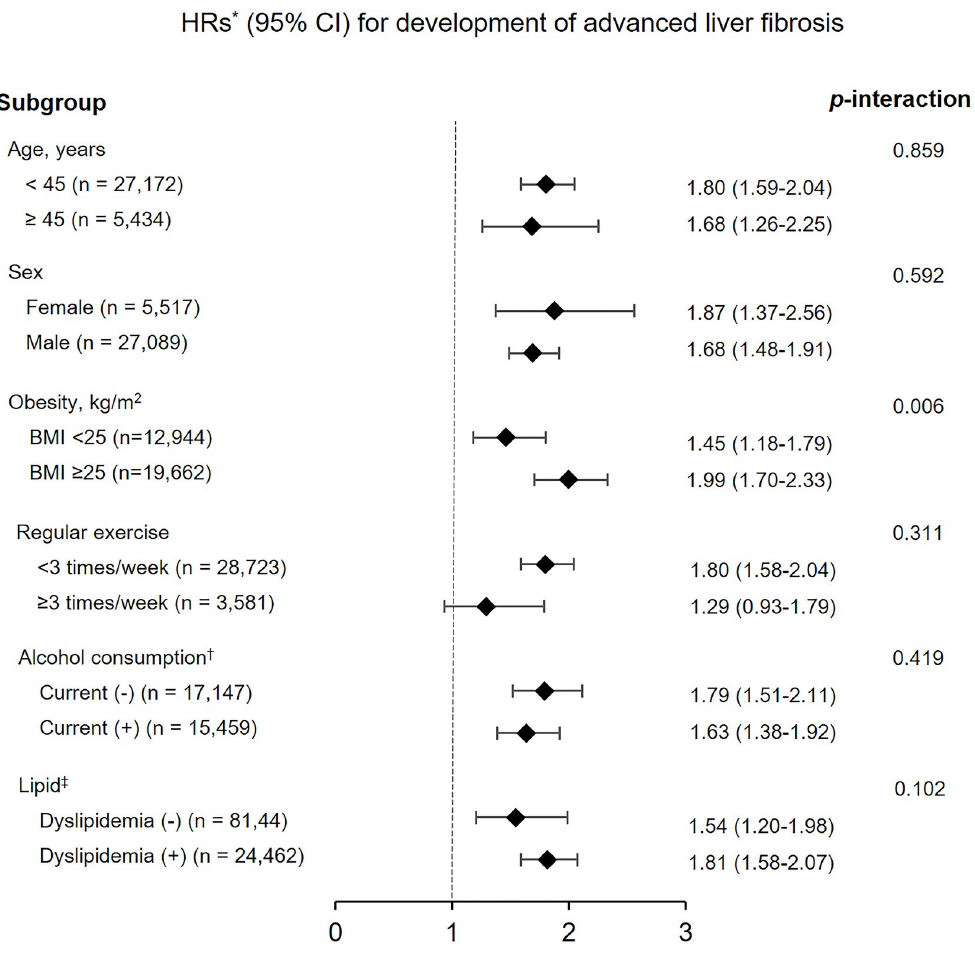
Fig 3. Subgroup analyses of hazard ratios for the development of advanced liver fibrosis (APRI value of � 0.5) in participants belonging to the highest baseline HOMA-IR quartile (Q4) compared with those belonging to the lowest baseline HOMA-IR quartile (Q1). � Adjusted for age, sex, year of examination, SBP, antihypertensive medications, regular exercise, current alcohol consumption, smoking status, BMI, waist circumference, HbA1c, hs-CRP, LDL cholesterol, HDL cholesterol, triglyceride, and use of antidyslipidemic drugs. † Current alcohol consumption defined as daily alcohol consumption above the median value (12 g/day for men, 2 g/day for women). ‡ Dyslipidemia was defined as total cholesterol � 200 mg/dL, triglyceride levels � 150 mg/dL, LDL cholesterol levels � 130 mg/dL, HDL cholesterol levels < 40 mg/dL in men and < 50 mg/dL in women, or use of antidyslipidemic drugs. Abbreviations: HOMA-IR, homeostasis model assessment of insulin resistance; SBP, systolic blood pressure; BMI, body mass index; HbA1c, hemoglobin A1c; hs-CRP, high-sensitivity C-reactive protein; LDL, low-density lipoprotein; HDL, high-density lipoprotein; HR, hazard ratio; CI, confidence